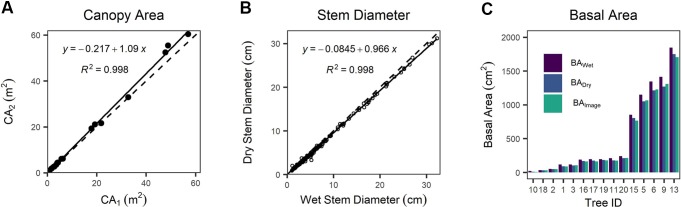

(A) Comparison of canopy area (CA)1 versus CA2 as different measurements of canopy area, (B) comparison between wet (field) versus dry (lab) measurements of stem diameter, and (C) comparison between basal area measured via image analysis (BAImage) of dry disks and basal area calculated from the equivalent stem diameter (ESD) of the wet (BAWet) and dry wood (BADry). In (A, B) dashed lines represent the 1:1 relationship, and solid lines are fitted linear regression models.